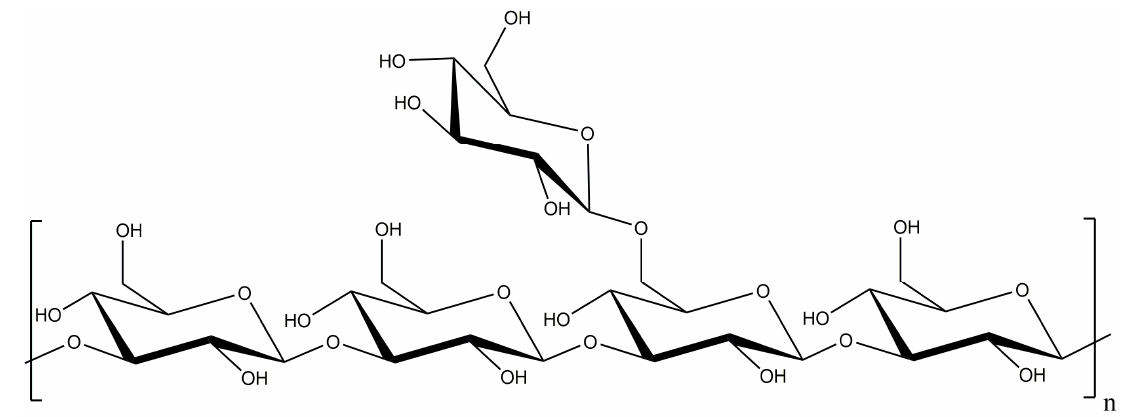
Figure 1. General Structure of Laminarin.